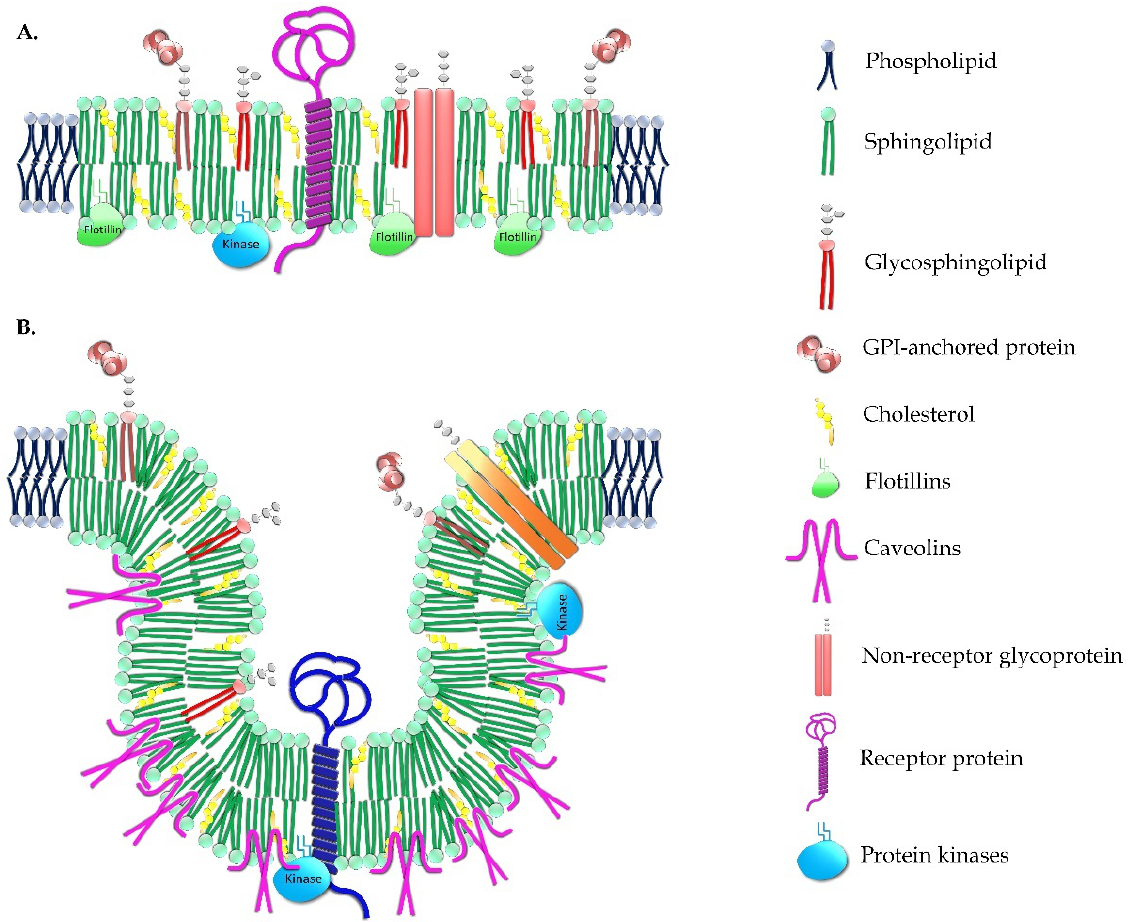
Figure 2. Specialized cell membrane domains. ( A ) non-caveolar lipid rafts and ( B ) caveolae. The different protein and lipid components are represented. Adapted from [39].